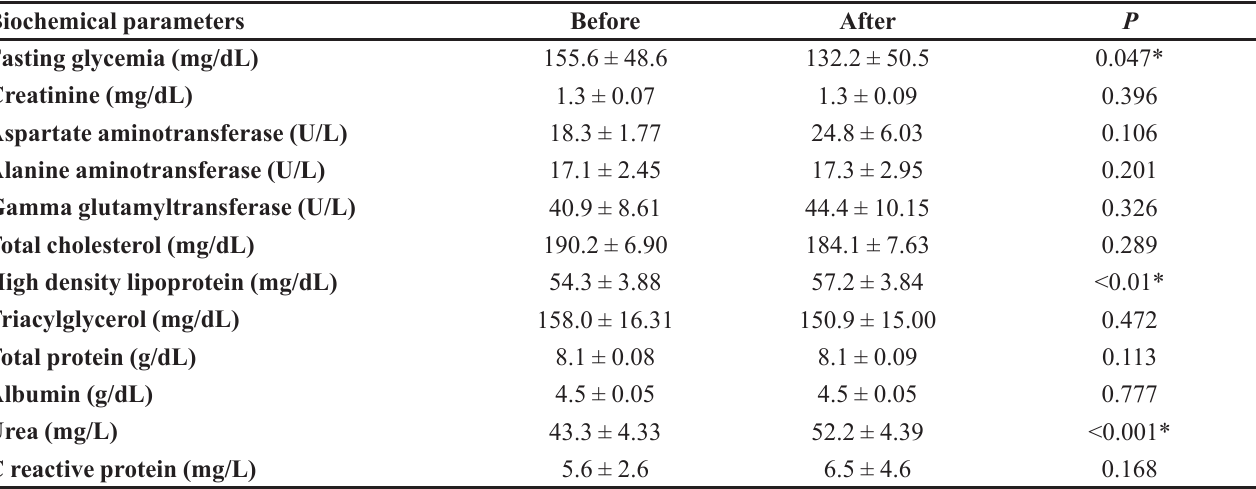
TABLE II - Biochemical and toxicological parameters (mean ± standard error) of diabetic patients before and after supplementation with glutamine dipeptide. Number of patients = 18 Biochemical